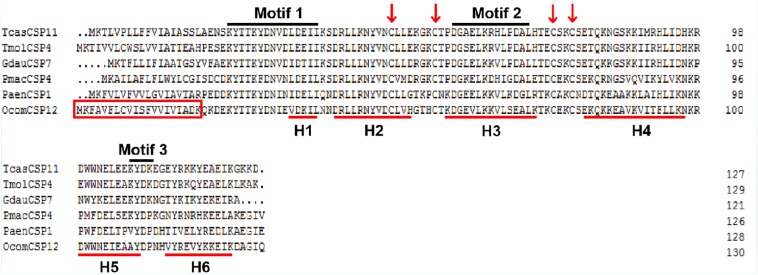
Alignment of the complete amino acid sequence of OcomCSP12 and five other CSPs of coleopteran insects. The signal peptides of OcomCSP12 are in the red box; the four conserved cysteine residues are marked with a red arrow; the six predicted α-helices are indicated by red underlines; three conserved motifs are under black lines. Tcas, Tribolium castaneum; Tmol, Tenebrio molitor; Gdau, Galeruca daurica; Pmac, Pyrrhalta maculicollis; Paen, Pyrrhalta aenescens.